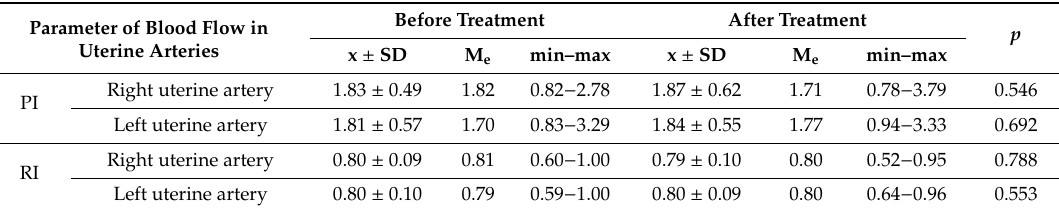
Table 7. The mean values of the PI and RI of the right and left uterine arteries before and after 3 months of treatment with ulipristal acetate ( n = 34 patients).